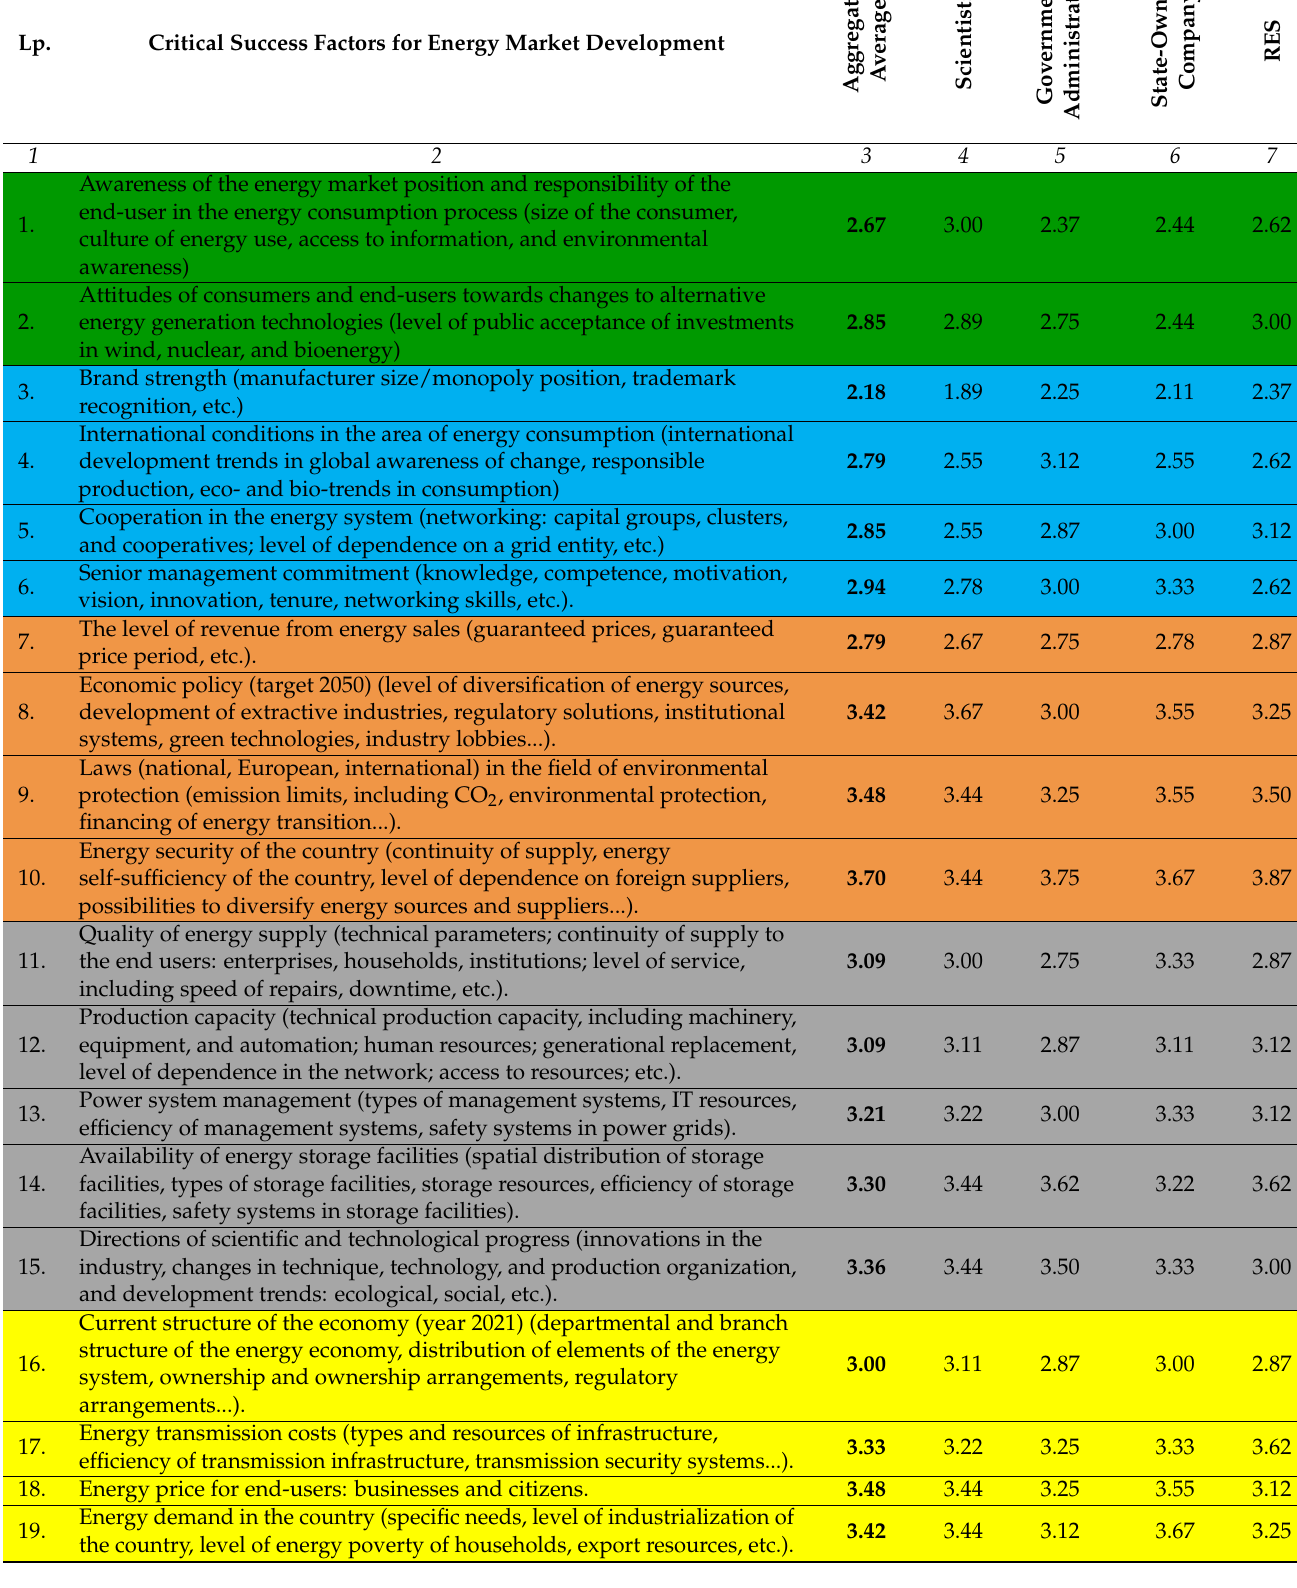
Table 6. CSFs significance level in the arrangement of the energy security needs